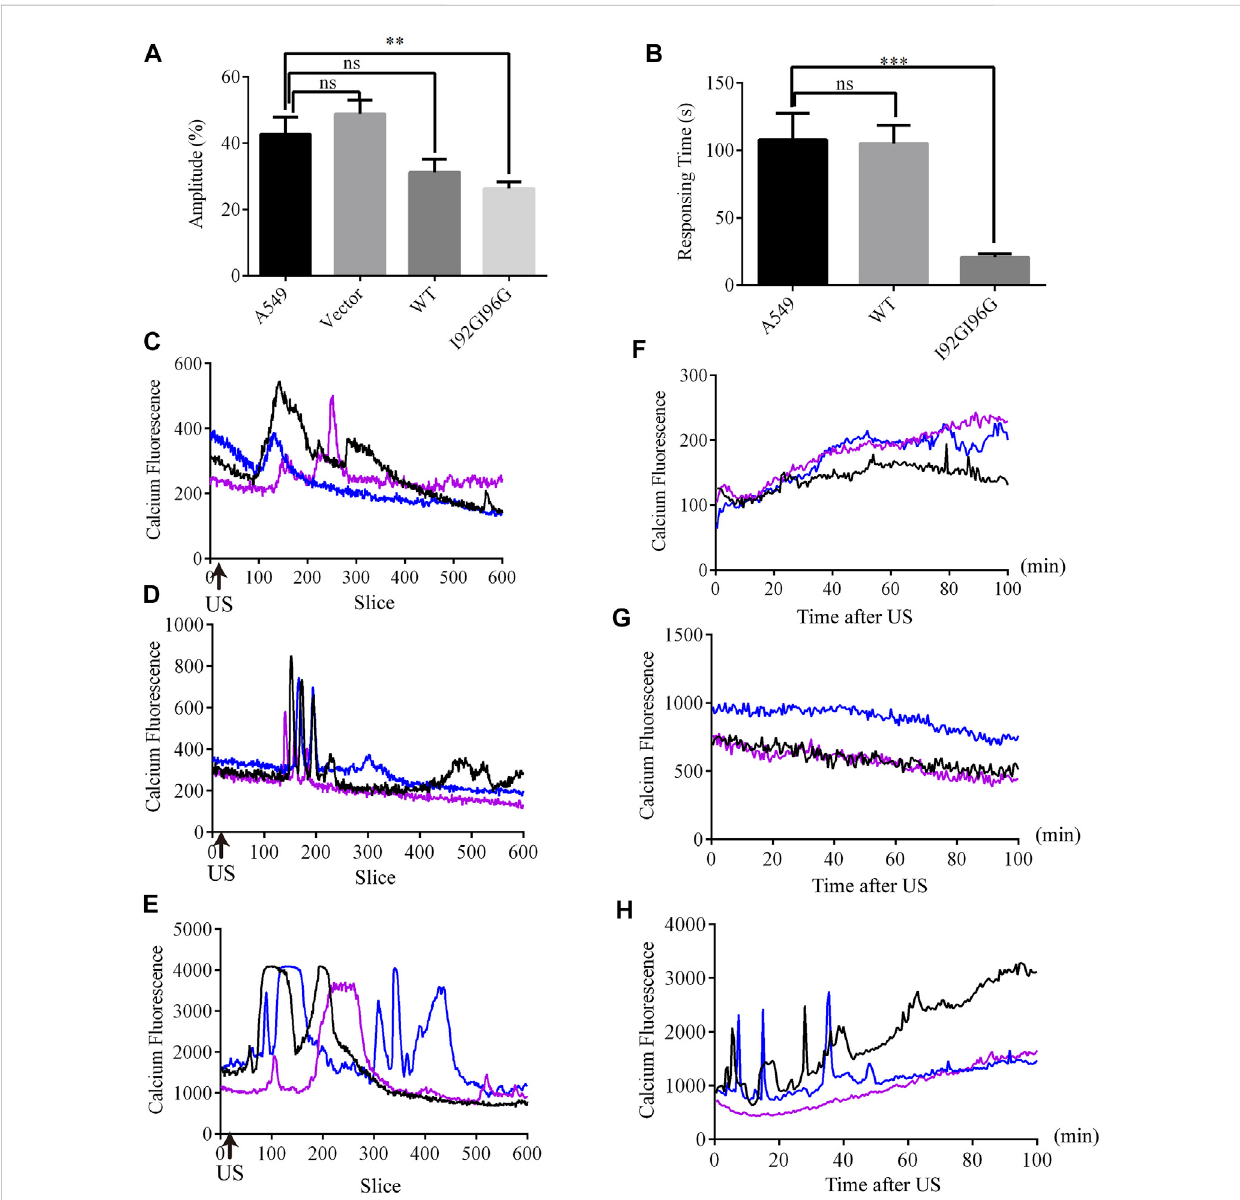
LIFUactivatesMscLchannelsinA549cells. (A) Thestatisticsofminimumsoundpressurethatcaused fl uo4 fl uorescencechange(mean±SEM,** p < 0.01,ns:nosigni fi cance). (B) ResponsetimeneededforA549cellsatthesoundpressureof0.053 MPa(equivalenttoIsppa:91.2 mWcm − 2 Ispta:15.2 mW cm − 2 ) (mean ± SEM, *** p < 0.001). (C – E) Recordings of real-time calcium fl uorescence when A549 (C) , WT-MscL. (D) or 192G196G-MscL, expressing A549cells (E) weretreatedwithultrasoundatthesoundpressureof0.053 MPa,arrowsindicatetheonsetofultrasound. (F – H) Recordingofcalcium fl uorescence after treated 10 min with ultrasound at the sound pressure of 0.053 MPa in A549 (F) , WT-MscL (G) or I92GI96G-MscL expressing A549 cells (H)